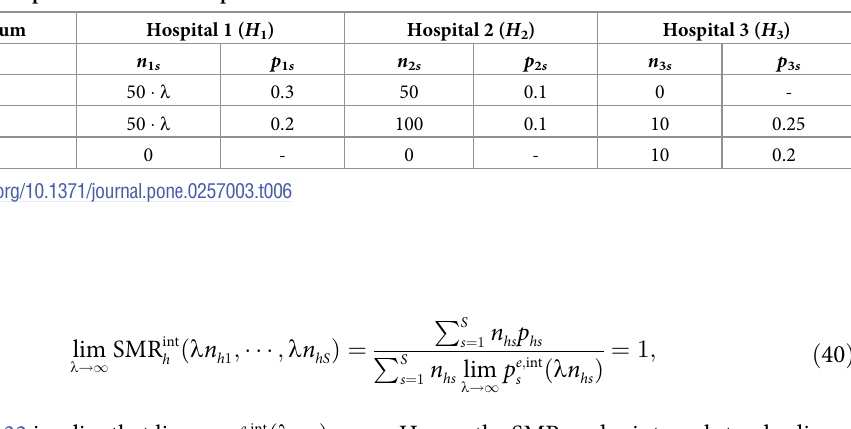
Table 6. Example of variations of hospital size under internal standardization: Parameter